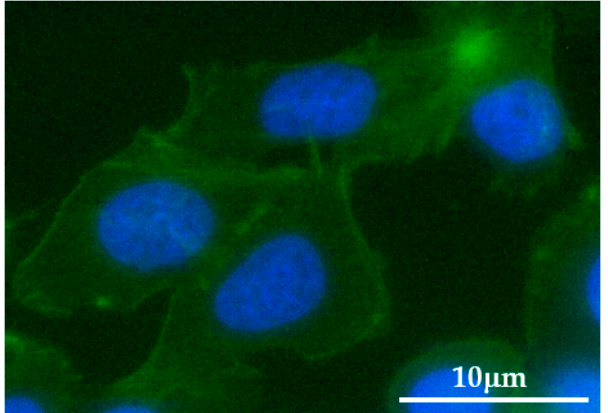
Figure 3. Images after double-cell staining with FITC-phalloidin (green) and Hoechst 33258 (blue) in SKBR3 control cells.